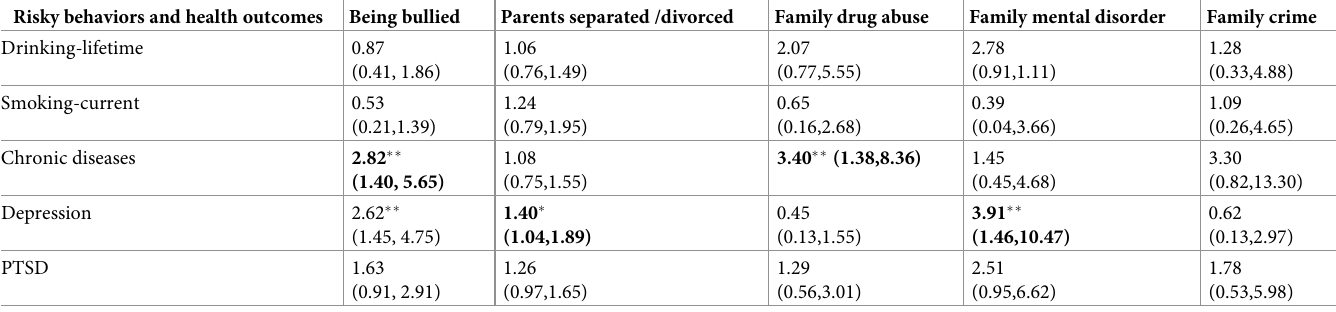
Table 5. Multivariate logistic regression models for relationship between ACE categories and risky behaviors and health outcomes. Risky behaviors and health